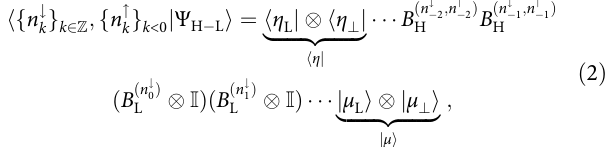
retical prediction for the Laughlin γ ð x ! þ1Þ ¼ log Halperin γ ð x ! (cid:2)1Þ ¼ log